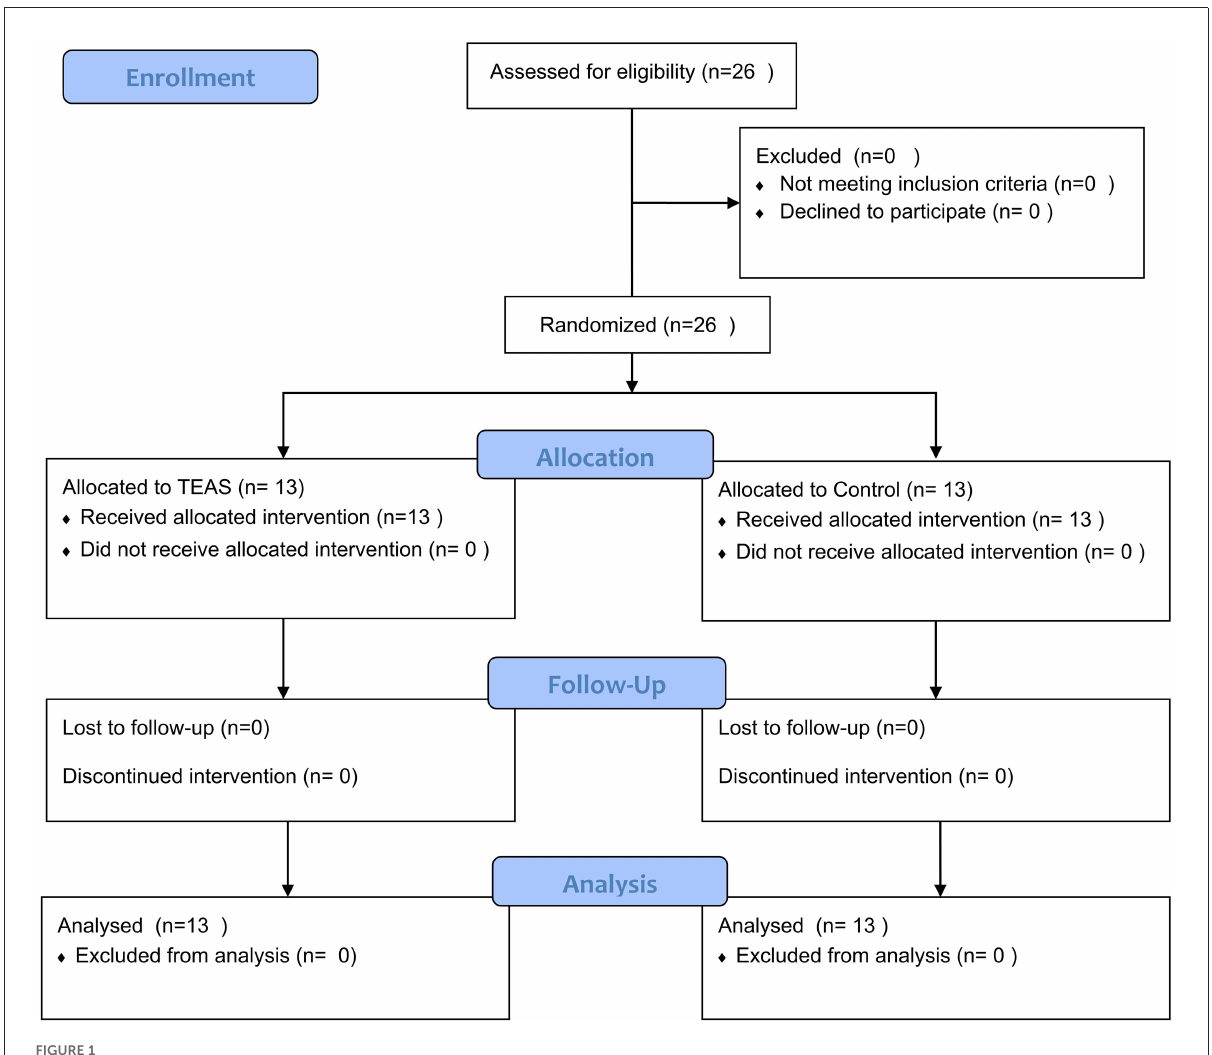
FIGURE1 Flowchart of participant’s